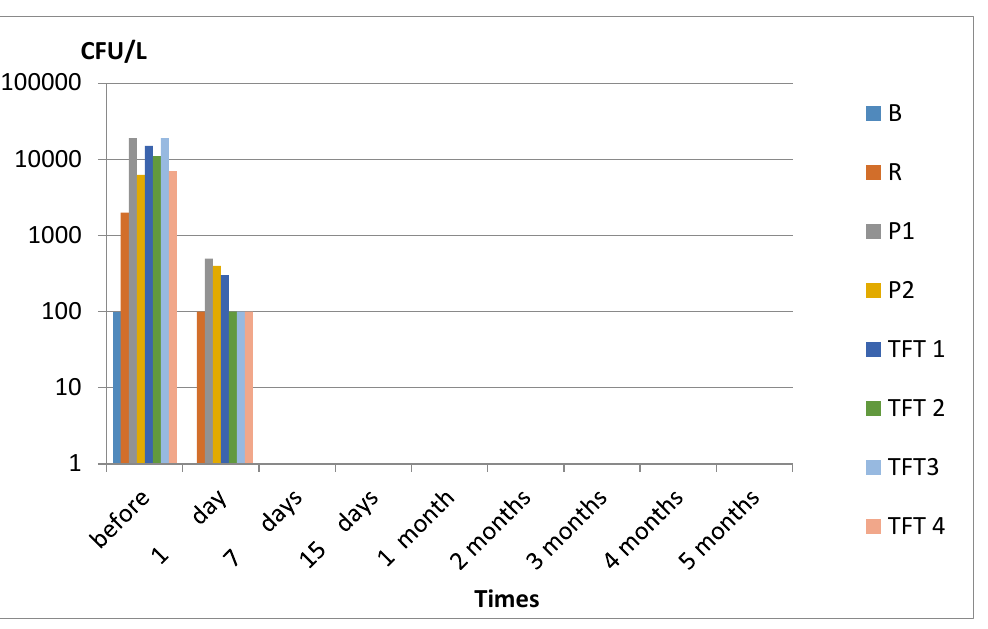
Table 1. Mean values of physical–chemical and chemical parameters assessed at each sampling points before and after TFT installation in Hospital 1. B = boiler; R = recirculation; P1 = point 1; P2 =